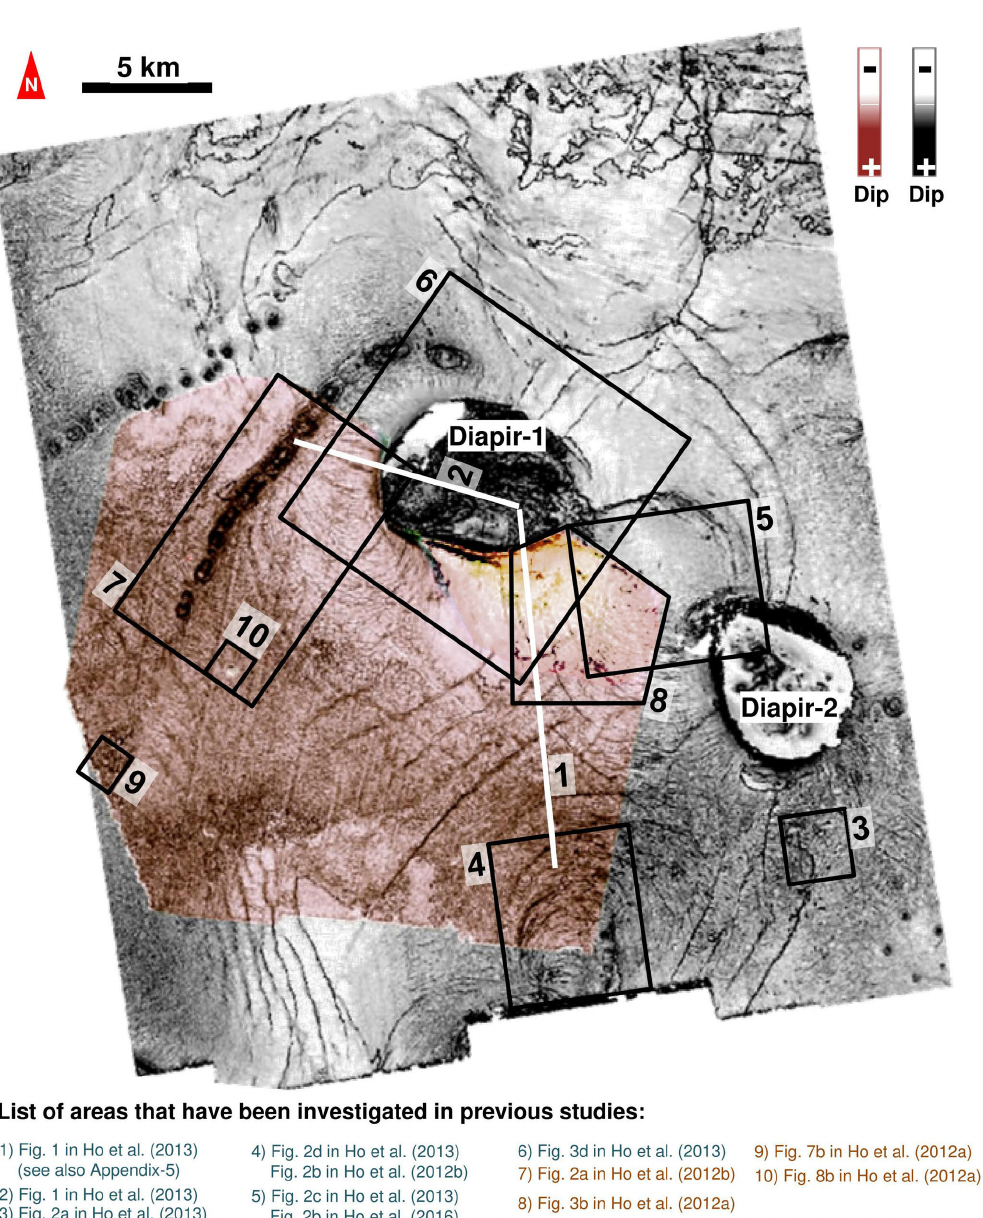
Figure A1. The areas investigated in previous studies (Ho, 2013; Ho et al., 2012, 2013, 2016) are shown on the dip map of horizon 5.3Ma. Superposition of the high-resolution survey (pink area) and the regional survey (grey